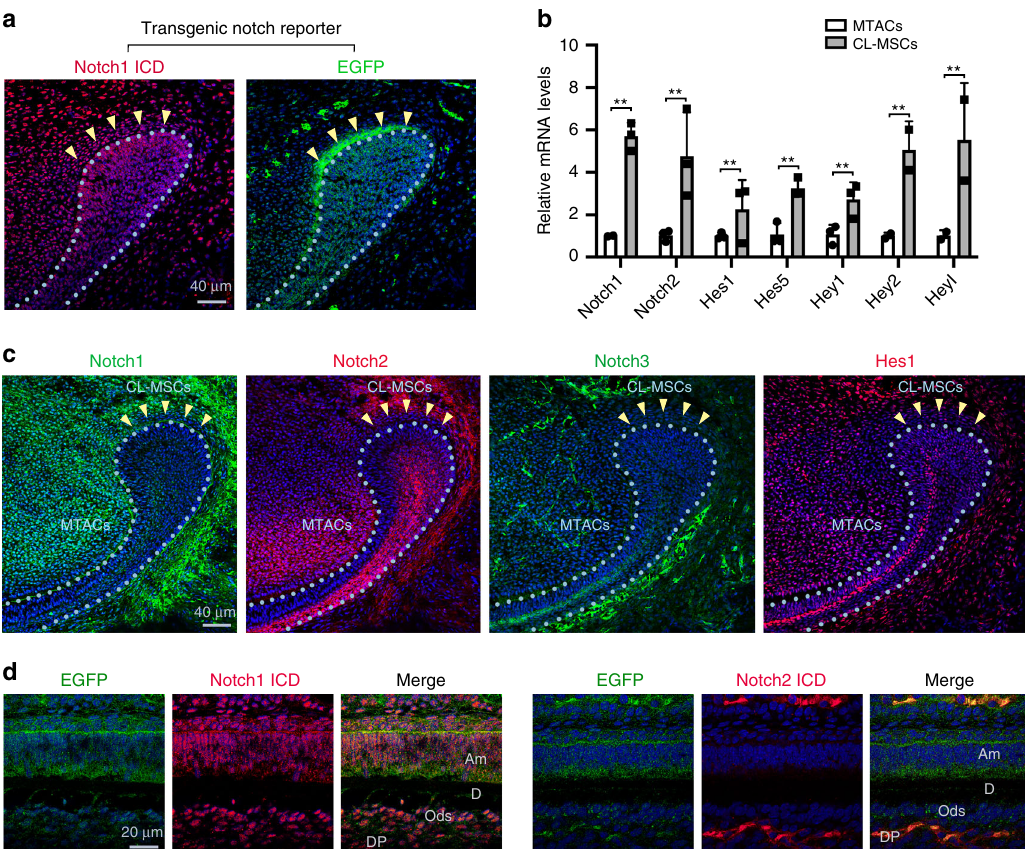
Fig. 4 Notch pathway is dynamically modulated in mouse incisor MSCs and TACs. a Double staining of Notch1 ICD and EGFP on lower incisor CL region of P5 transgenic TNR mice. Nuclei were counterstained with DAPI. b Real-time RT-PCR pro fi ling of mRNA expression of the Notch receptors and downstream targets for MTACs and CL-MSCs from n = 5 biologically independent animals. Triplicated samples were used for each gene. Error bars represent standard deviation. Statistical analysis was performed with two-way ANOVA followed by Bonferoni correction. ** p < 0.01. c Immuno fl uorescence analysis of Notch 1 – 3 and Hes1 in the P7 incisor CL region. Nuclei were counterstained with DAPI. d Double staining of EGFP either with Notch1 ICD (left) or Notch2 ICD (right) on the differentiated labial enamel – dentin junction. Am ameloblasts, D dentin, DP dental pulp, Ods odontoblasts. Nuclei were counterstained with DAPI. Yellow arrows mark clusters of odontoblasts that were EGFP positive. Light blue dotted lines indicate epithelial – mesenchymal junctions. Bars: a and c : 40 μ m; d : 20 μ